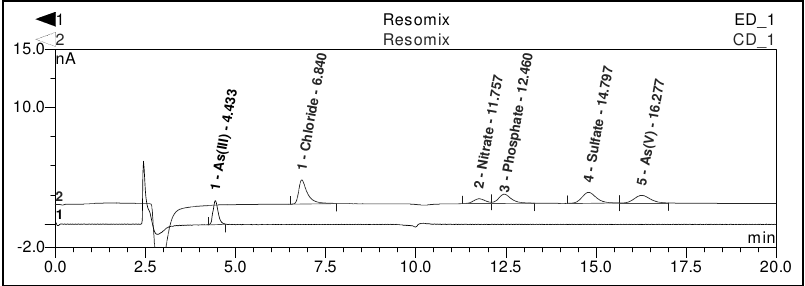
Figure 3. Linear calibration plot of arsenite and arsenate standard A resolution mixture of chloride, nitrate, phosphate, sulfate, arsenite and arsenate was injected into the ion chromatograph system. This run shows that the method is specific for arsenite and arsenate as shown in Figure 4.